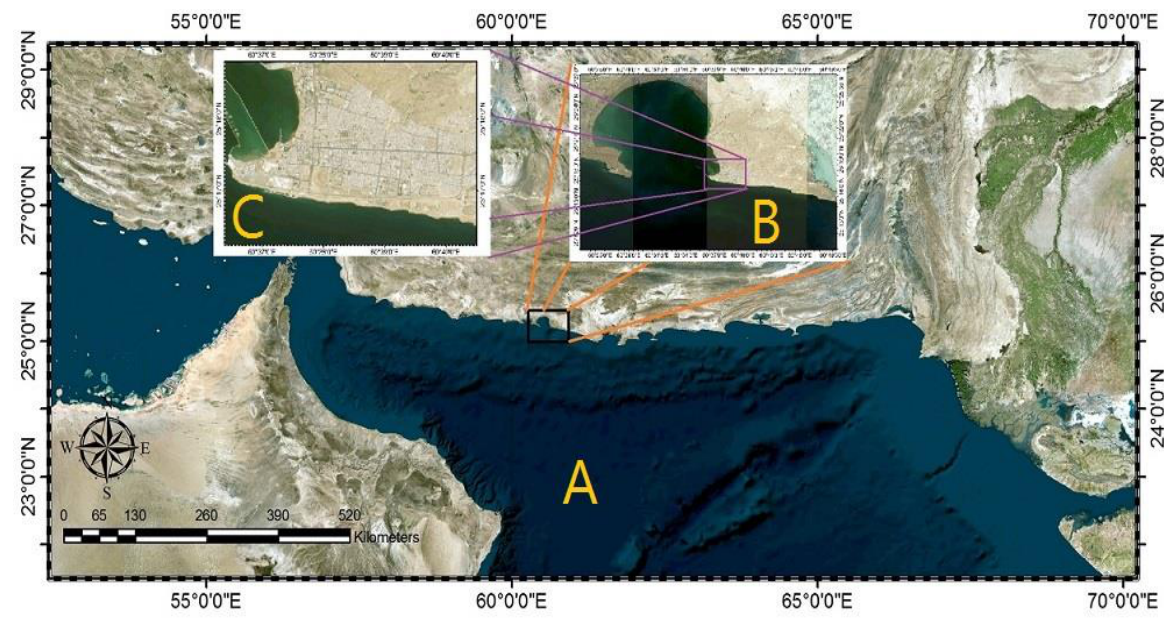
Figure 5. The study area used for Tsunami Simulation. The first layer is 980 meters resolution (A), the middle layer is 180 meters resolution (B) and the top layer Chabahar Port with 15 meters